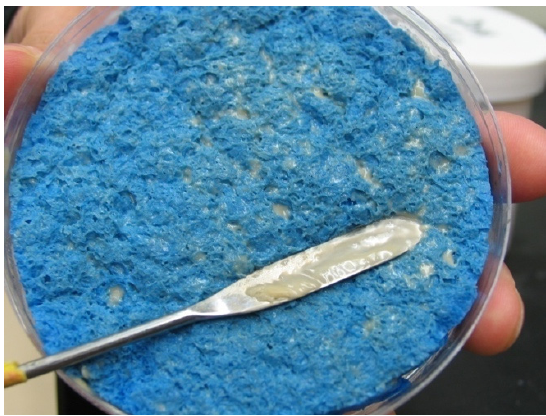
Figure 2. The yeast paste is evenly applied with a flat spatula over the sponge surface.